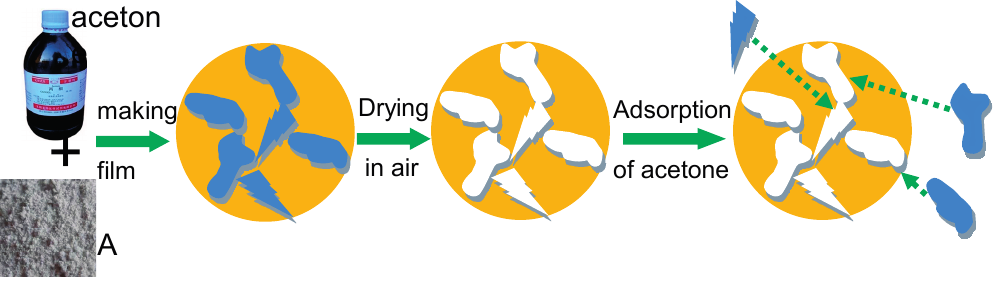
Figure 12. Schematic illustration of imprinting by acetone clusters on acetone-assisted SnO 2